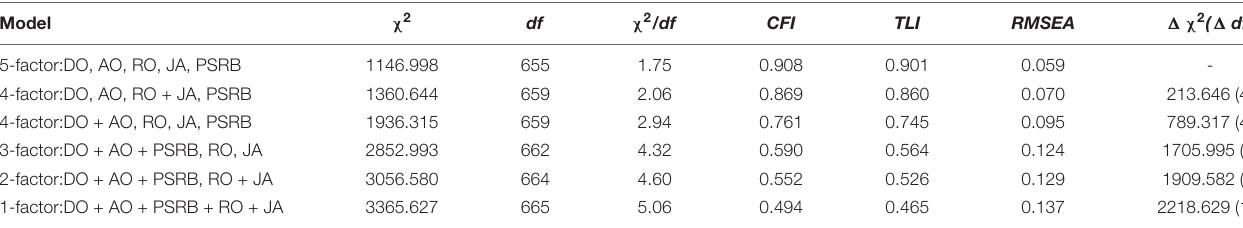
TABLE 1 | Results of the confirmatory factor analyses of study